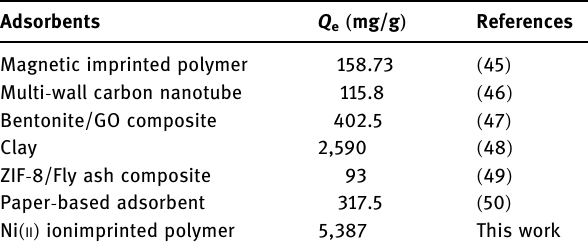
Table 5: Comparison of adsorption capacity of nickel ion using di ff erent adsorbents